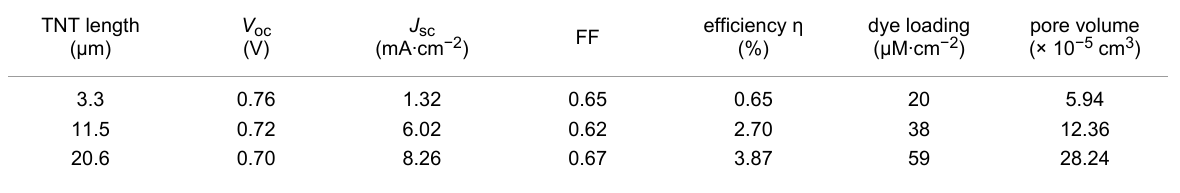
Table 1: Photovoltaic performances of N719-DSSCs using different TNT arrays under an AM 1.5 solar simulator.